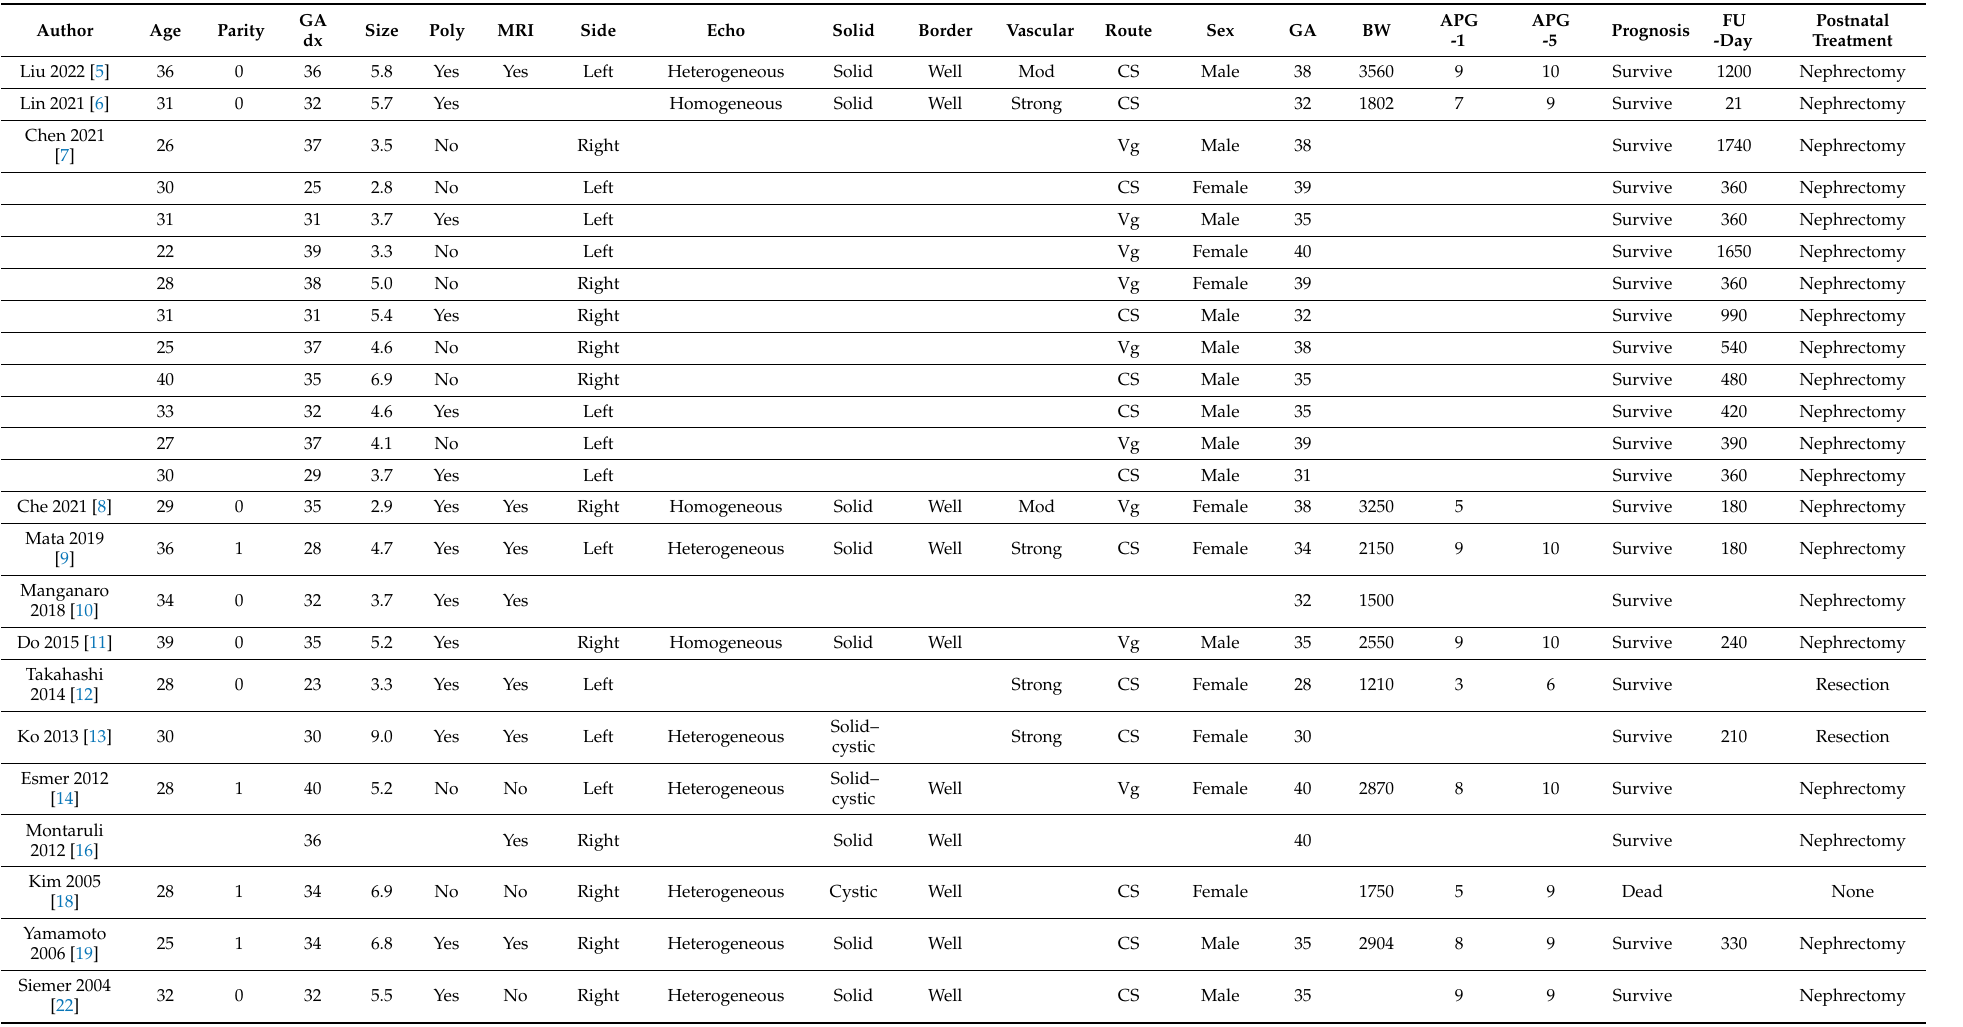
Table 1. Summary of the clinical and sonographic characteristics of individual case reports of congenital mesoblastic